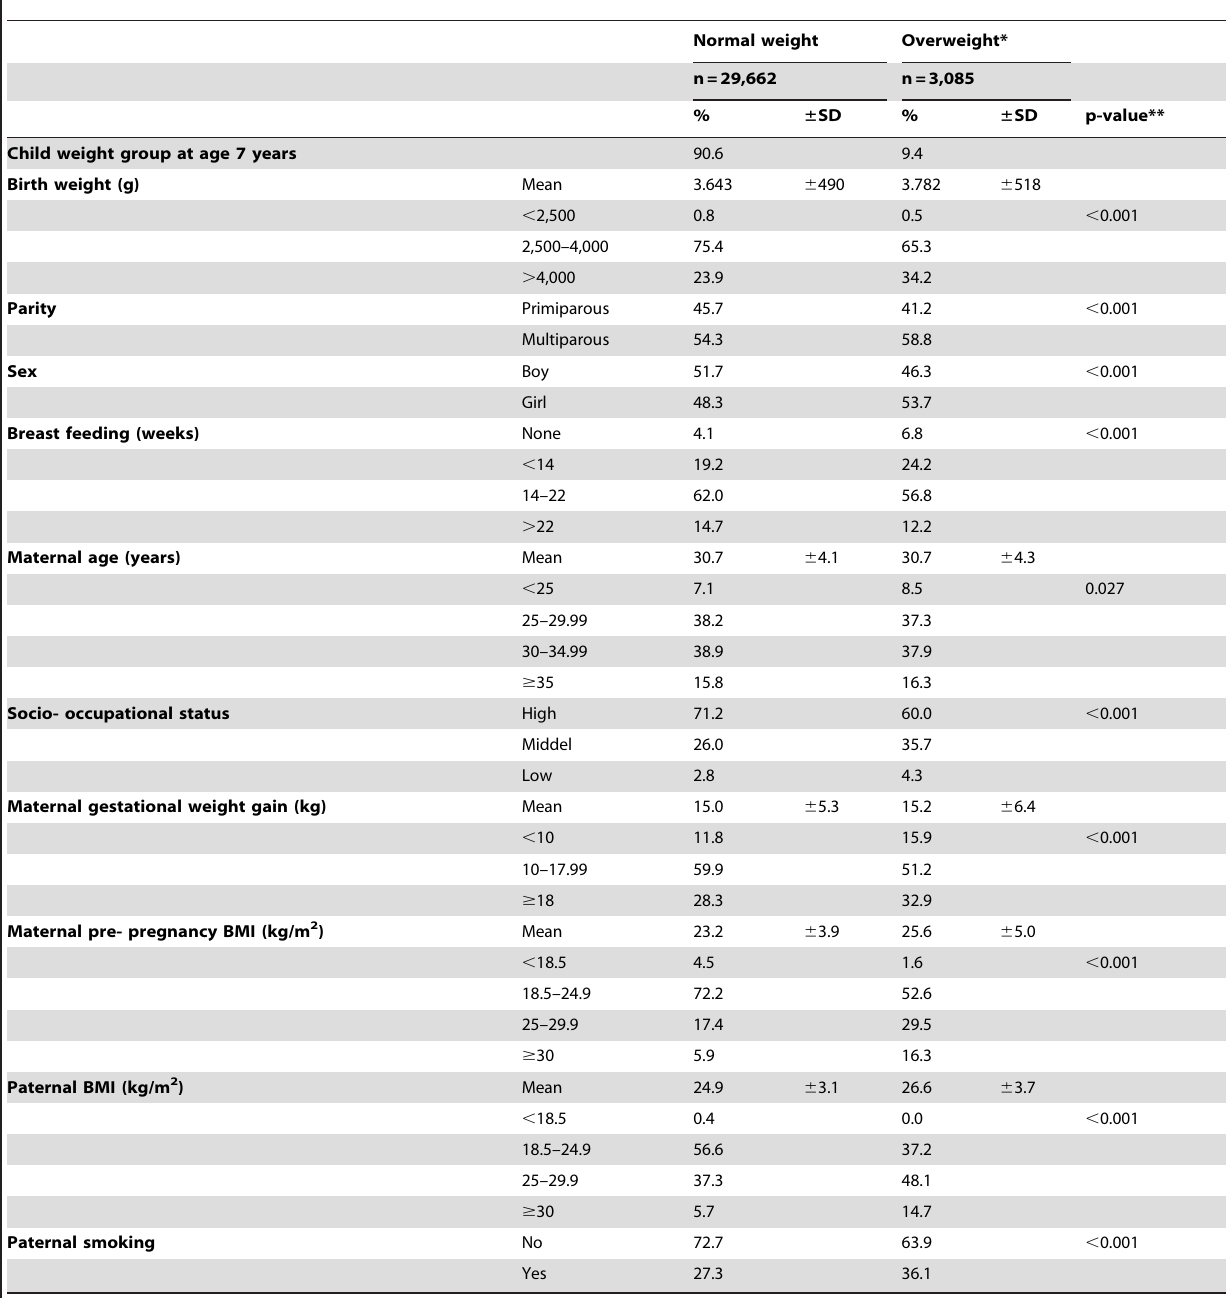
Table 2. Distribution of covariates according to normal weight and overweight children.